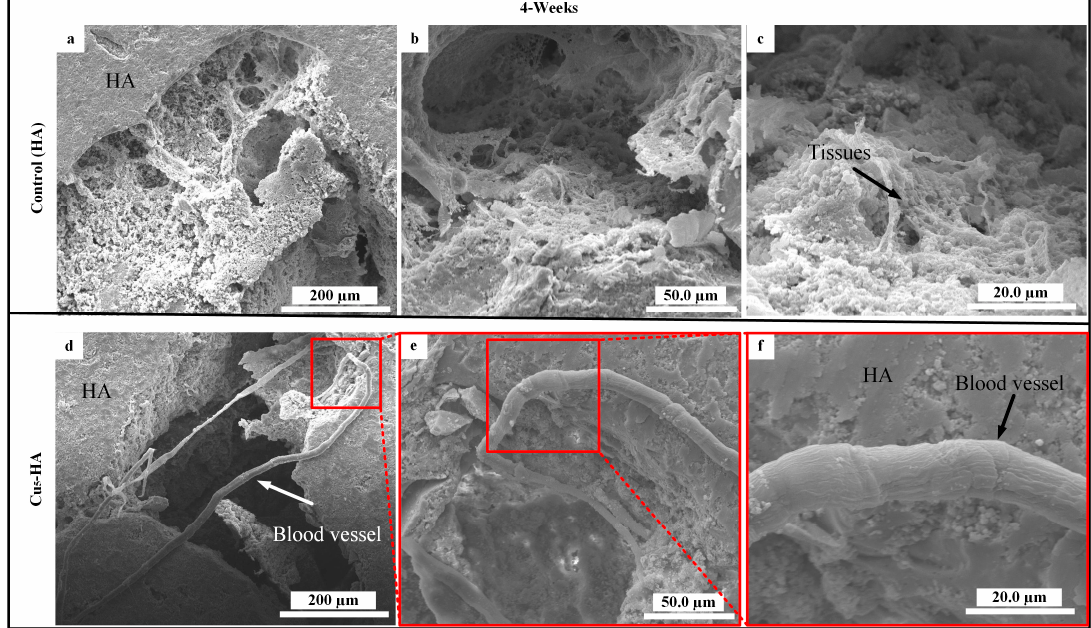
Figure 10. SEM high-magnification pictures characterized blood vessels on HA and Cu 5 -HA after four weeks of implantation: ( a , c , d ) no blood vessels formed on the HA scaffolds and ( d , e , f ) blood vessels formed on the Cu 5 -HA scaffold.